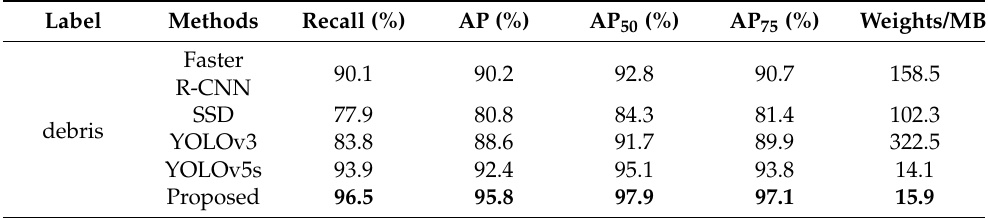
Table 2. Quantitative results based on the SWFD dataset. The most impressive results are highlighted in bold.